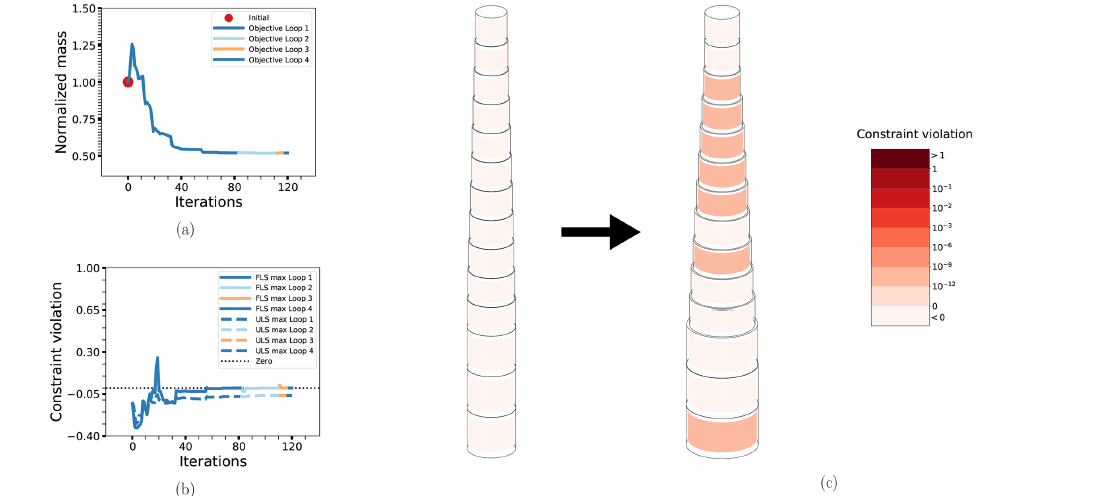
Figure 14. The optimization process for case OC3-PA-NW: the objective function (a) , maximum non-linear constraint violations (b) and the change in the design from initial to final configuration (c) . Details as in previous figures.